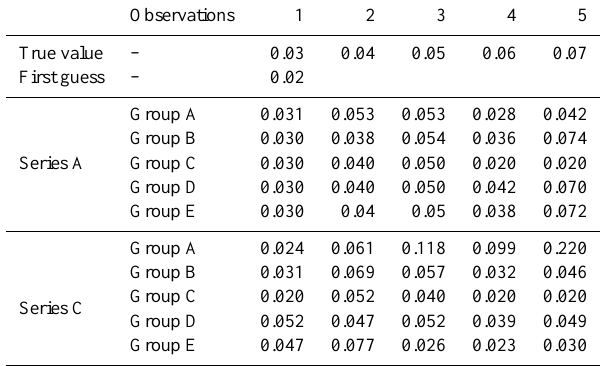
Table 2. The identified Manning’s n in experiment series A and